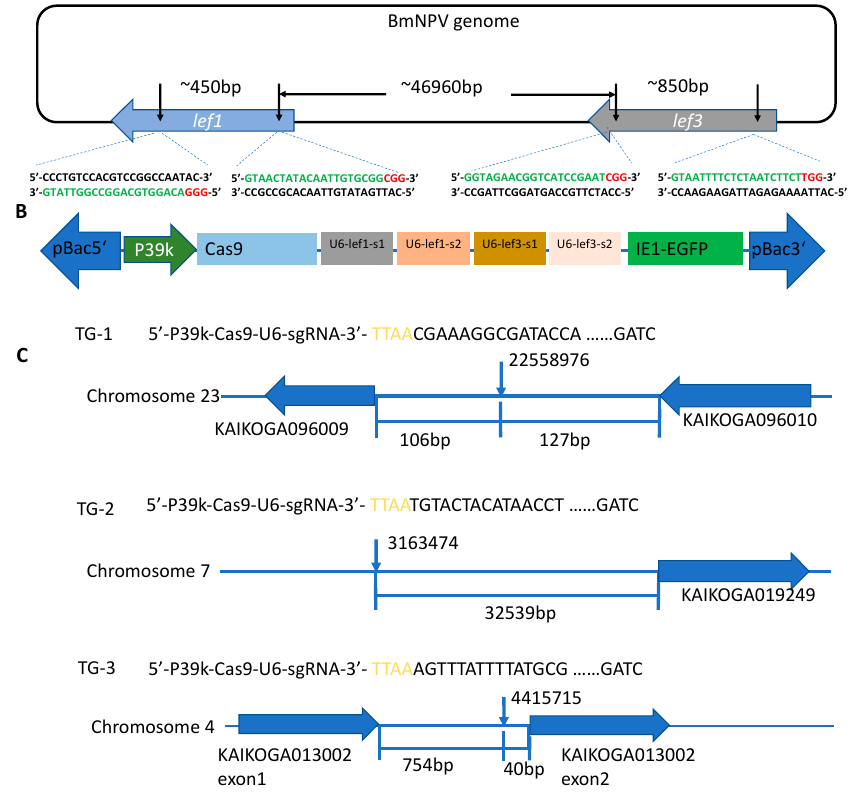
Figure 1. Construction of the BmNPV-inducing and targeting CRISPR/Cas9 gene-editing system in the silkworm. ( A ) Schematic representation of the locations of sequences targeted by sgRNAs in lef-1 (blue arrow) and lef-3 (grey arrow) in the BmNPV genome. The sgRNA target sequences are green, and the PAM sequences are red. The distances between target sites are given in base pairs. ( B ) Design of the pBac -EGFP- P39k - Cas9 /4 × gRNAs construct. The green arrow represents the 39k promoter and the blue box represents the cas9 coding region. The gray, blue, brown, and pink boxes represent sgRNA expression cassettes targeting lef-1 -s1, lef-1 -s2, lef-3 -s1, and lef-3 -s2, respectively. The green box represents the EGFP expression cassette. ( C ) Schematic of insertion sites of the pBac-EGFP- P39k-Cas9 /4 × gRNAs construct in the TG-1, TG-2, and TG-3 lines. The vertical arrows indicate the insertion sites. The horizontal blue arrows represent genes adjacent to the insertion sites in TG-1 and TG-2 and the gene disrupted in TG-3. The distances are given in base